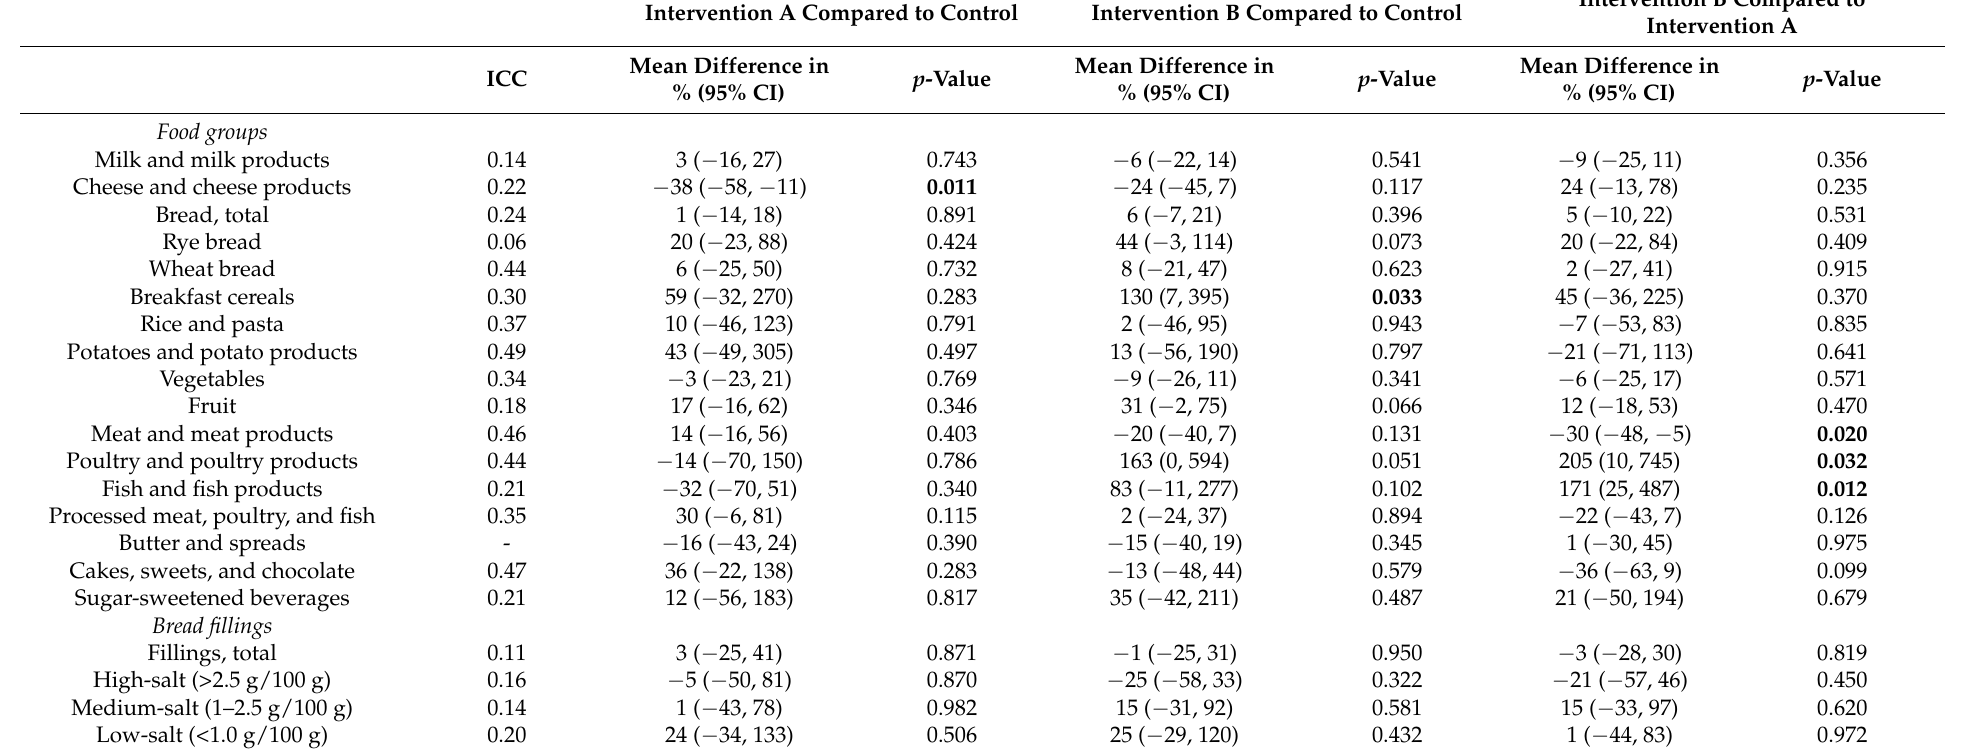
Table 4. Estimated differences between groups at follow-up in intake of food groups (g/10 MJ). Intervention A Compared to